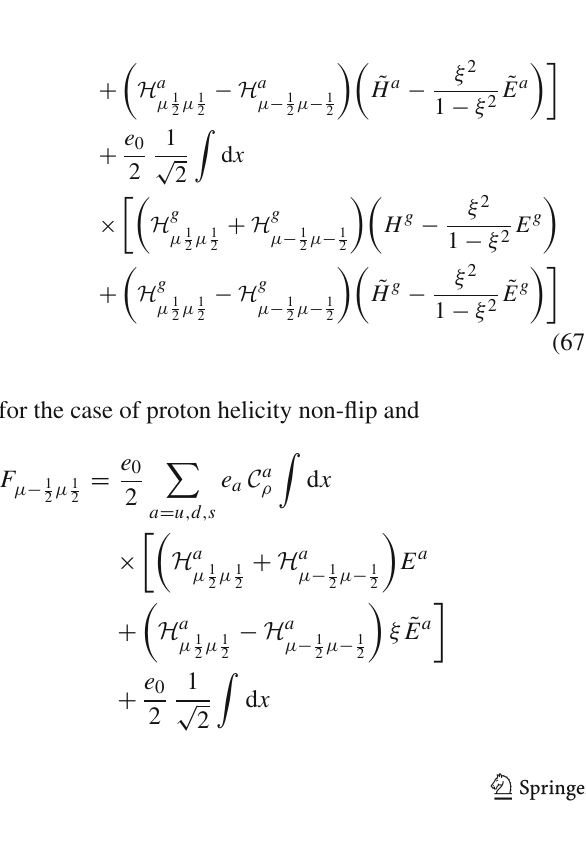
λ V λ (cid:2) V λ nally polarized. An additional scale uncertainty of 2% originating from Fig. 3 Comparison of the SDMEs u obtained from the amplitude γ λ (cid:2) γ theuncertaintyonthebeampolarizationispresentfortheseSDMEs,but method ( red circles ) and from the SDME method ( blue triangles ). The not shown. The inner ( outer ) error bars represent the statistical (total) SDMEs are extracted in the entire kinematic region. For the amplitude uncertainty. The SDMEs are ordered according to the SDME classes methoda25-parameterfitisused,whiletheresultsoftheSDMEmethod proposed in Refs. are taken from the HERMES data in Ref. [17]. The points in the shaded area show SDMEs that can be obtained only if the beam is longitudi-